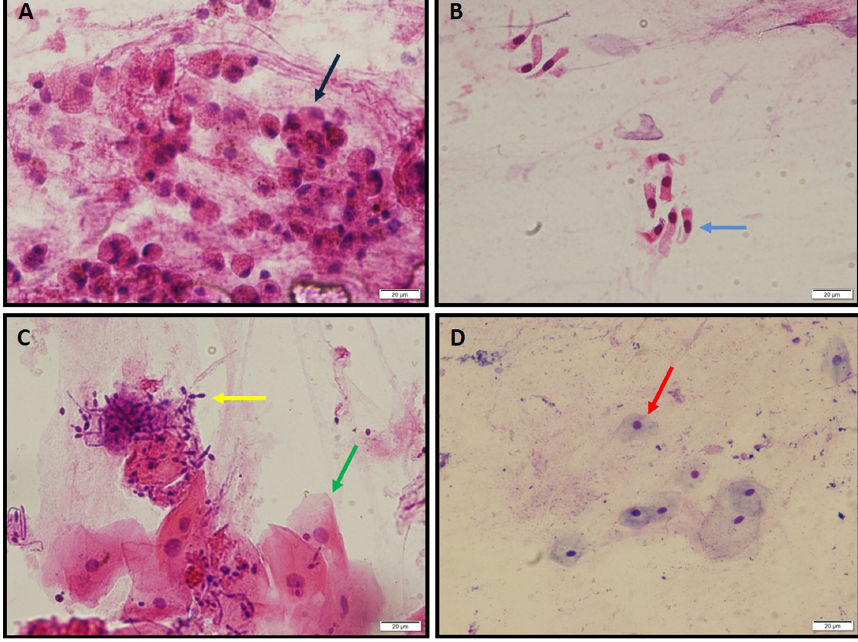
Figure 3. a-d. Histopathological examination of sputum samples (hematoxylin and eosin × 20), (a and b) Sputum sample with sufficient criteria, black arrow: alveolar histiocyte, blue arrow: bronchial epithelial cell. (c and d) Insufficient cytological material, oropharyngeal content, yellow arrow: candida hyphae and spores of oral flora, green and red arrow: squamous epithelial cells of the oral